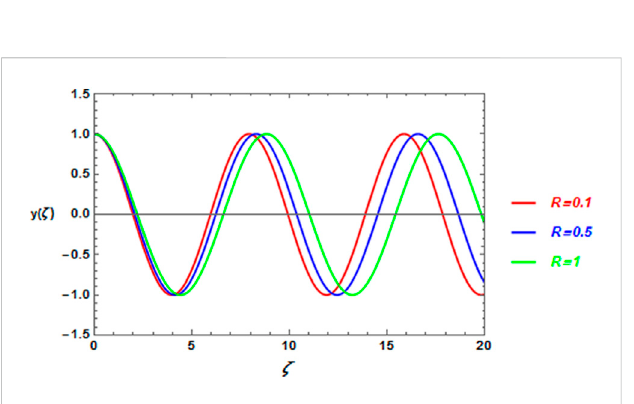
FIGURE 4 In fl uence of the parameter R on the periodic solution Eq. 32.